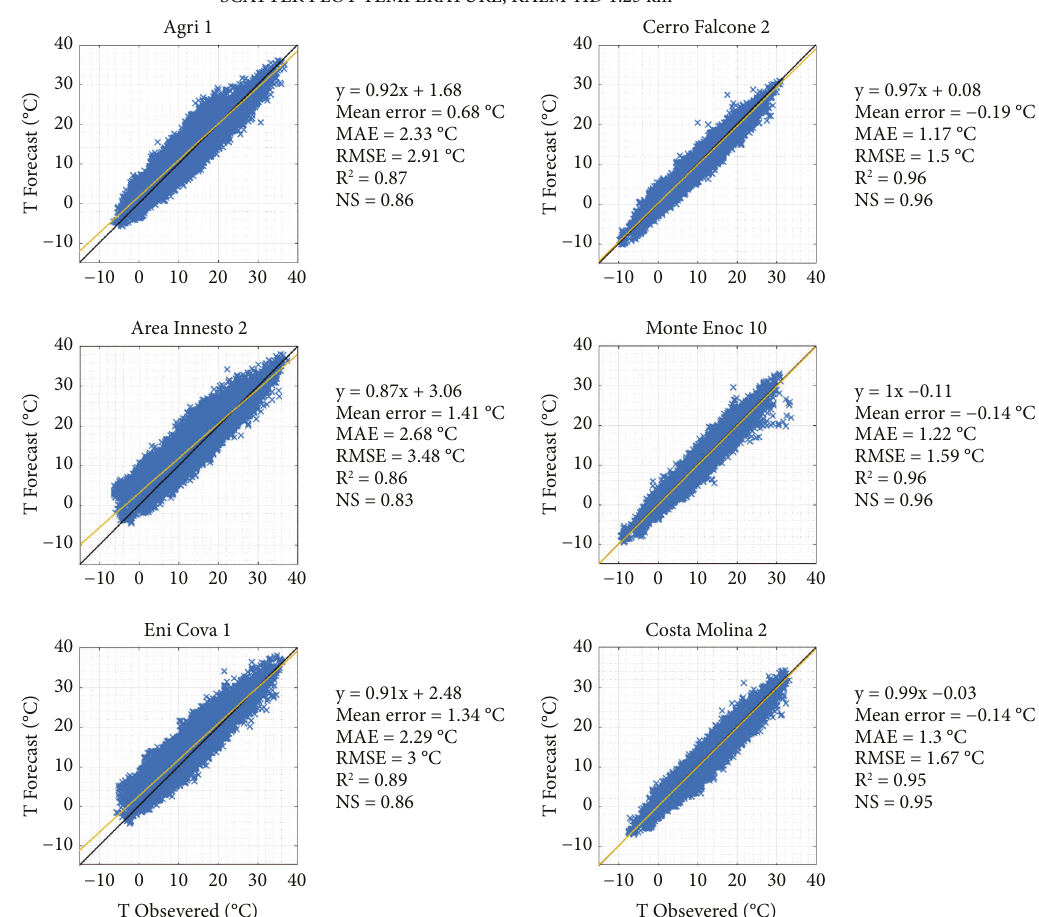
Figure 6: Scatter plots of the KALM-HD model with 1.25km as grid resolution vs. observed data for the hourly temperature forecast over the six stations at day +1 as lead time for the whole two years of the observation period. On the left are the “valley stations,” and on the right are the “mountain